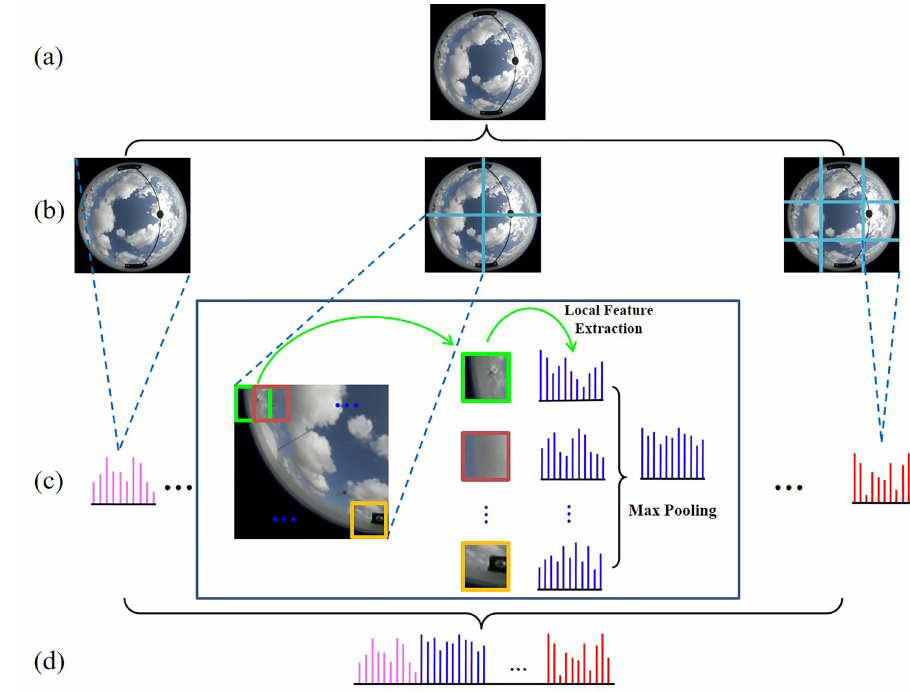
Figure 5. ( a ) An original cloud image; ( b ) the original cloud image is divided into l × l regions with different scales l = 1, 2, 3; ( c ) feature extraction and representation; ( d ) the final feature representation of the cloud